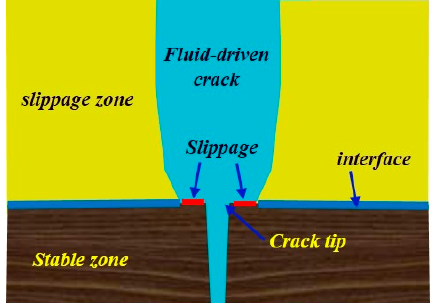
Figure 6. Interface slippage at fracture tip.